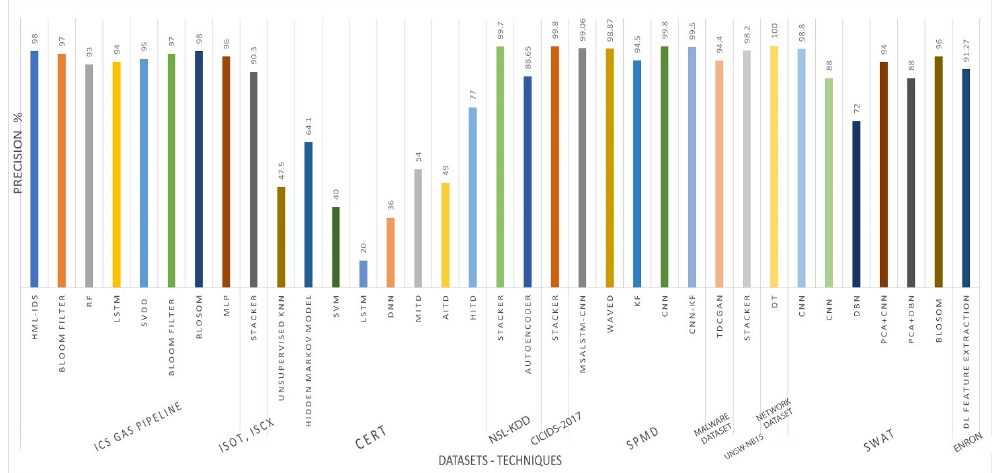
Figure 6. Precision of the compared techniques on different